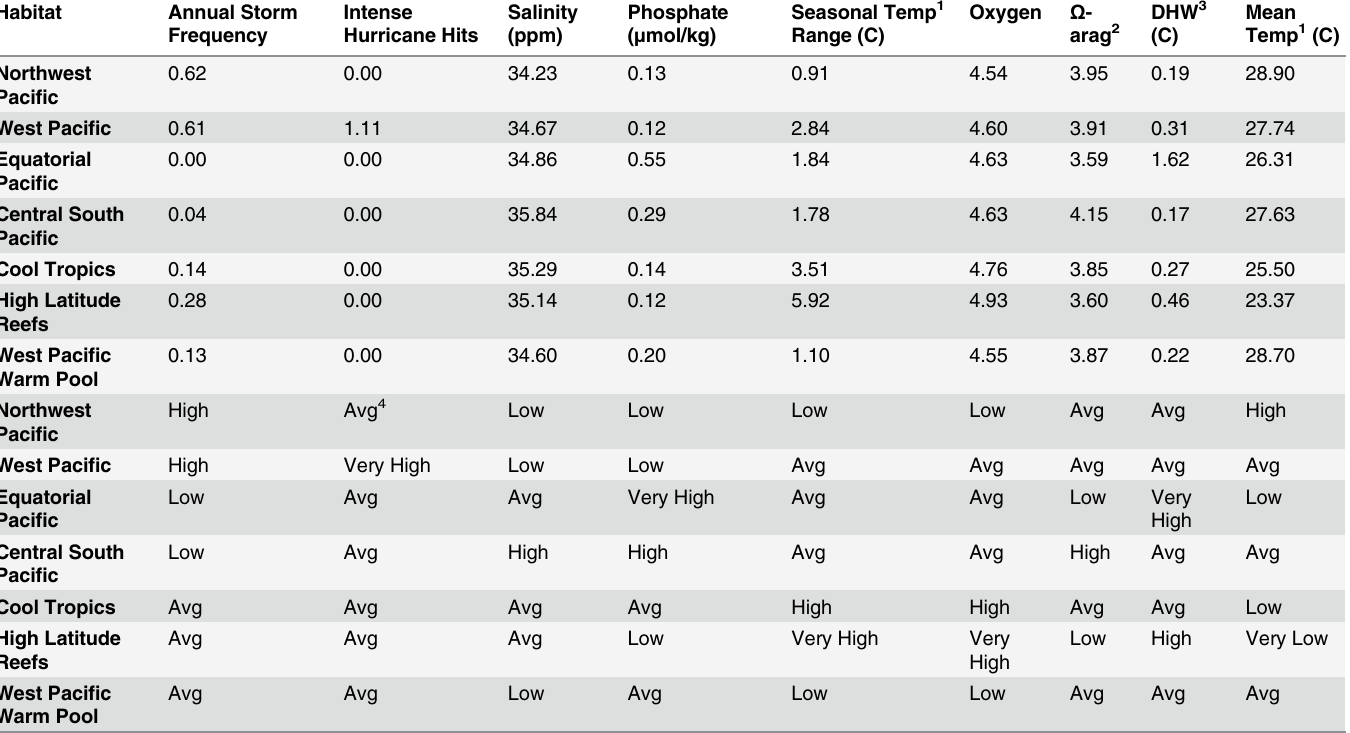
Table 2. Description of Coral Reef Habitats.